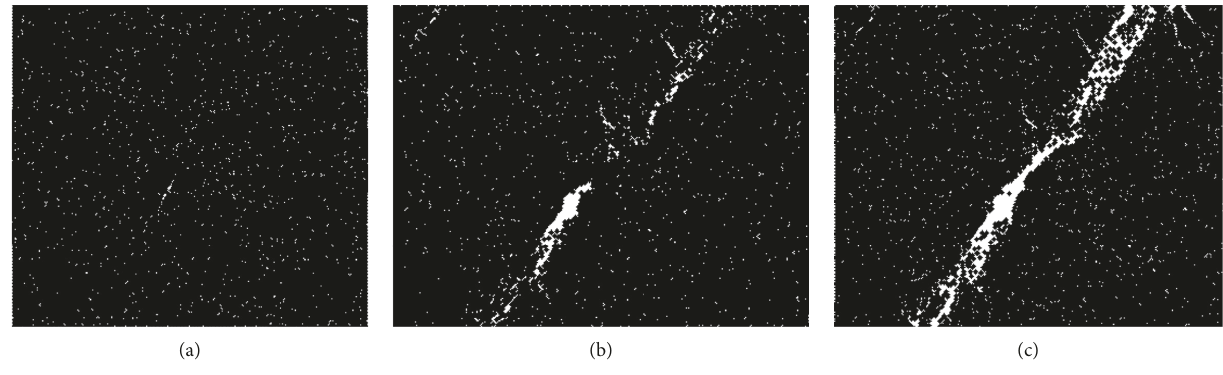
Figure 7: Simulated creep fracturing process: (a) t � 4000s; (b) t � 10500s; (c) t �